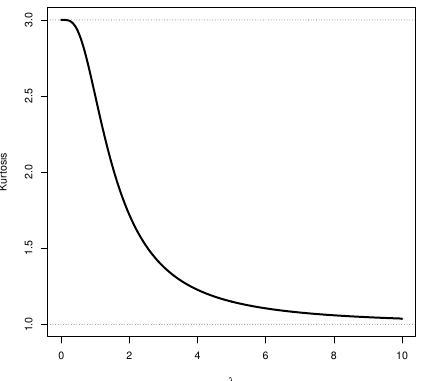
Figure 2. Plot of kurtosis coefficient of TN for different values of λ